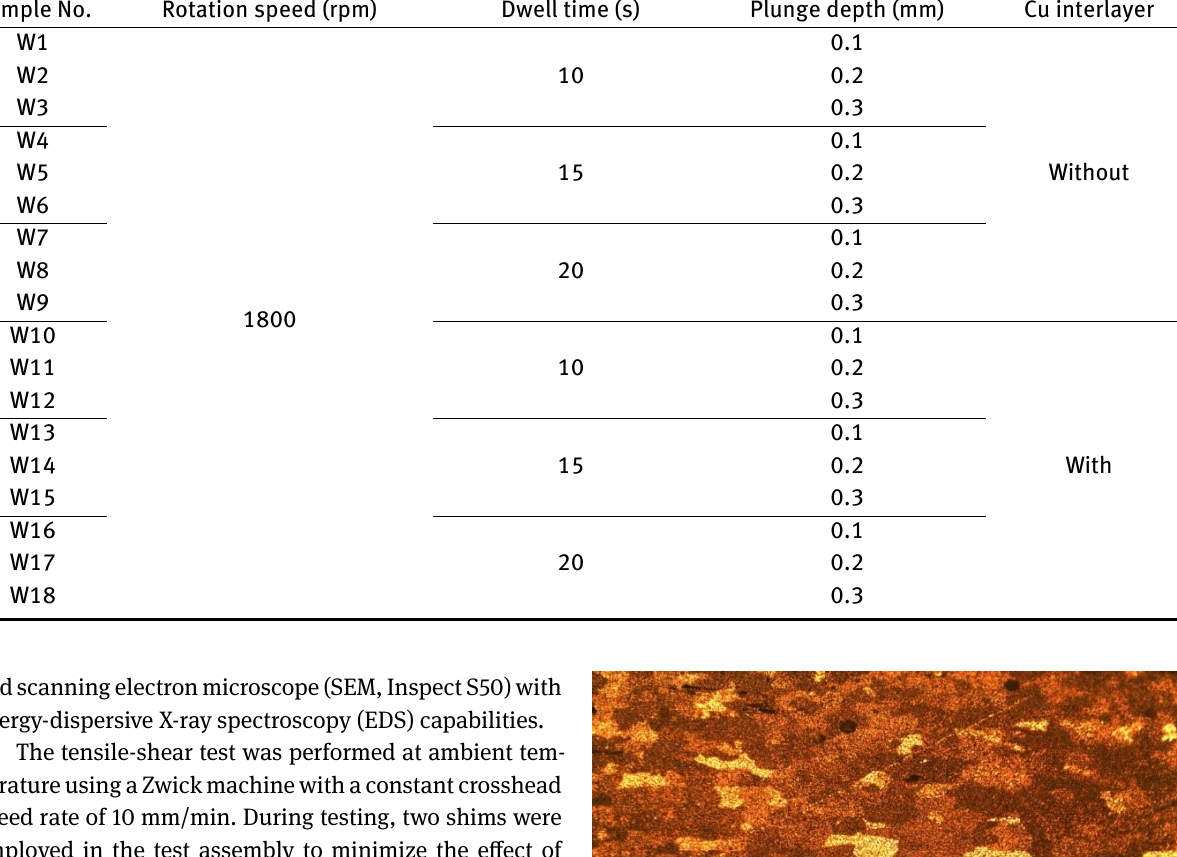
Table 3: Welding parameters of the P-FSSW Sample No.